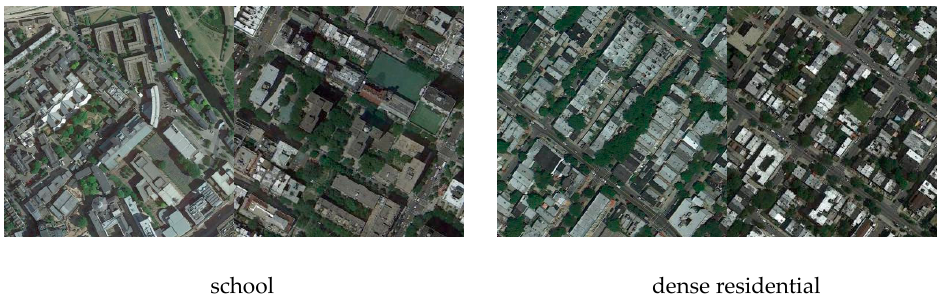
Figure 1. Sample images labelled school and dense residential in the AID dataset.